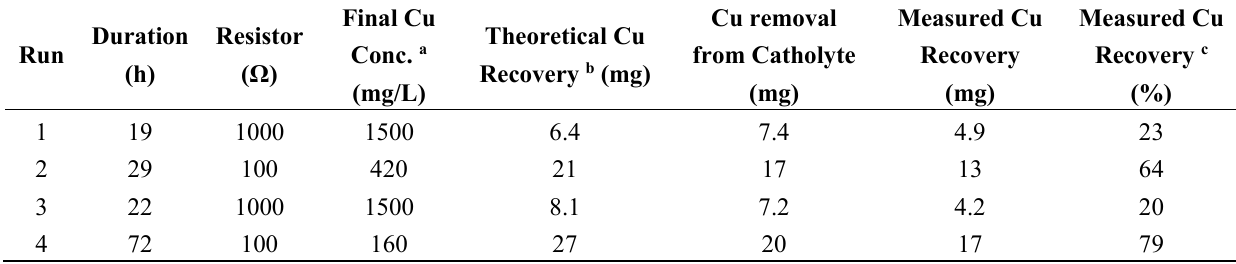
Table 3. Cu recovery from leachate in the microbial fuel